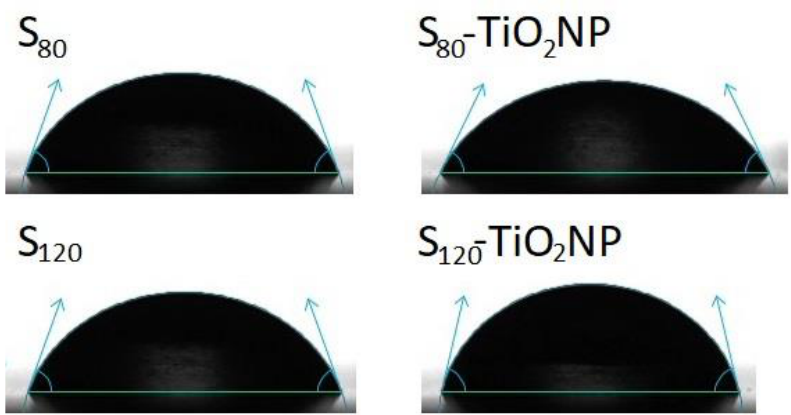
Figure 5. Image of the drop of distilled water deposited on the surface of the films.